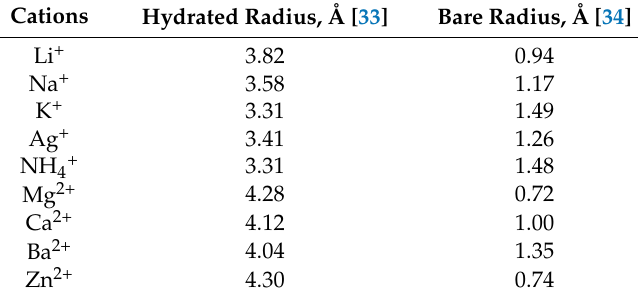
Table 2. The cation radius of the used